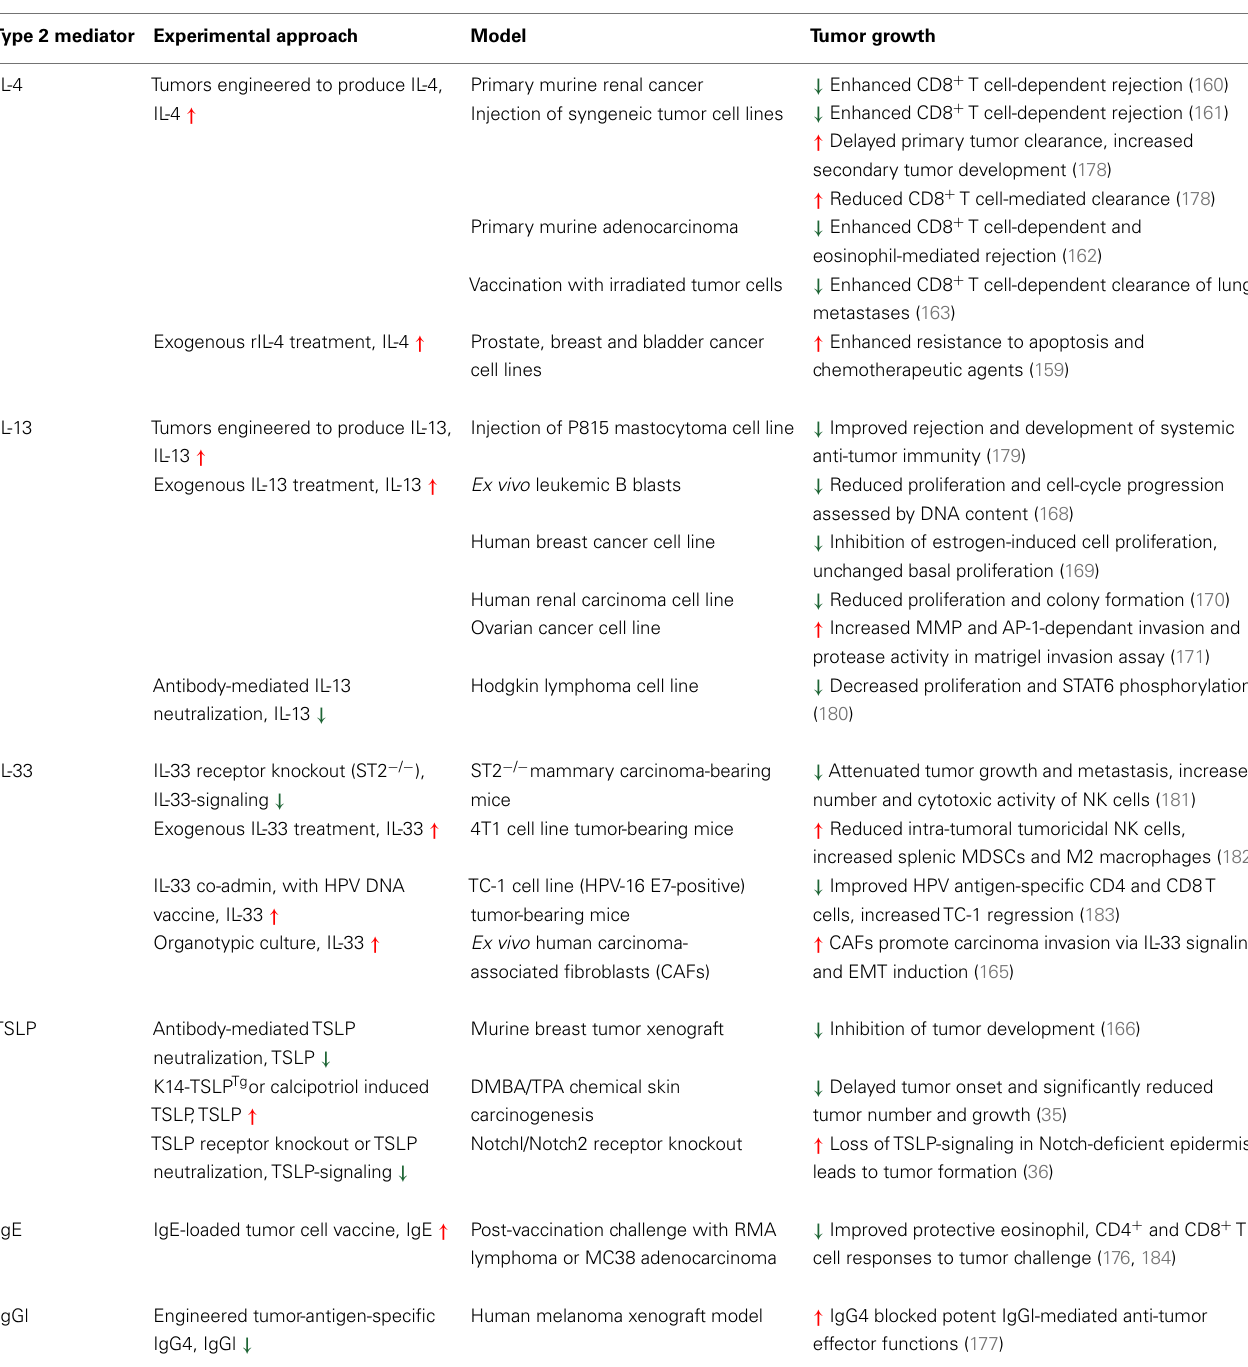
Table 1 | Examples of type 2 cytokines and immunoglobulins influencing tumor pathology